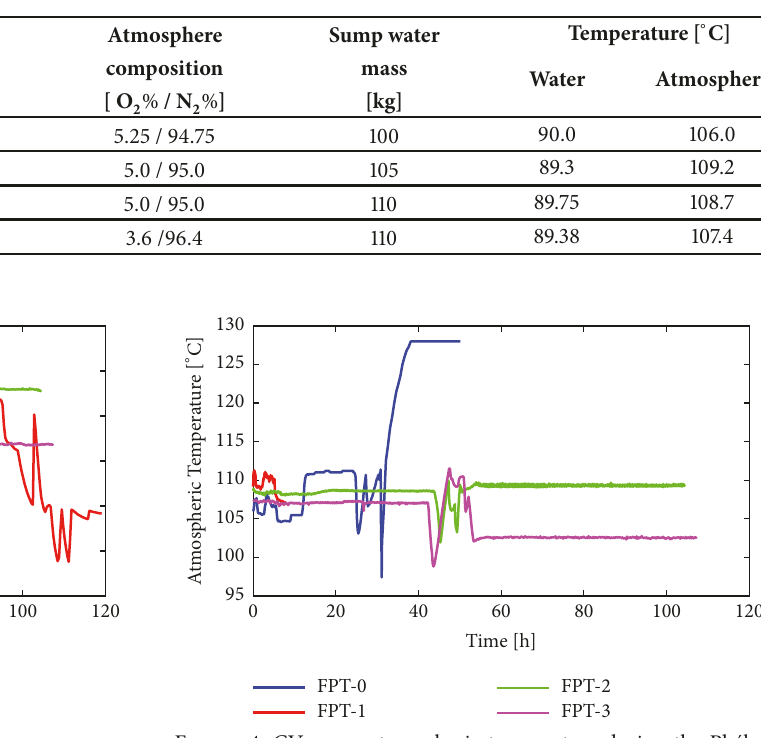
Table 3: Main initial conditions of the Ph´ebus FPT tests.